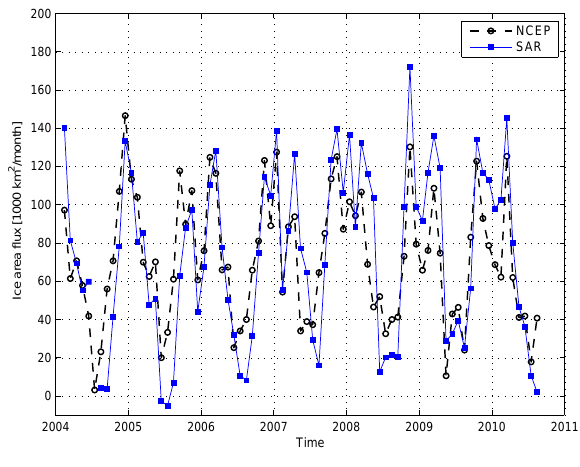
Fig. 4. Monthly ice area export values based on SAR velocity com- pared to the NCEP pressure difference formula (Eq.